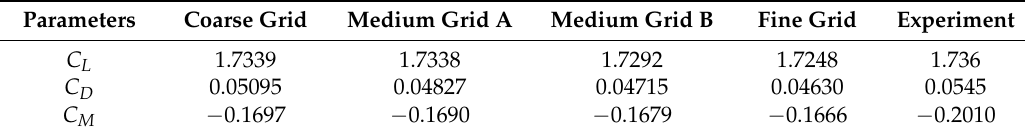
Table 3. Comparison of aerodynamic coefficients at AoA = 11.05 ◦ .